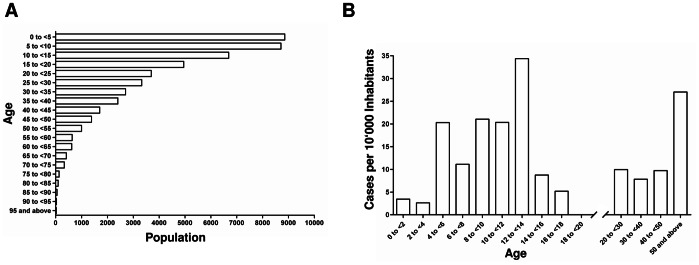
Population age distribution and age adjusted cumulative BU incidence rate in the Bankim HD.In the course of the exhaustive survey, data on the population age structure of the Bankim HD were collected (A). Using this age distribution and the ages of the RT-PCR confirmed BU cases which occurred inside of the Bankim HD (n = 62), the age adjusted cumulative BU incidence rate (cases per 1'000 inhabitants) for the duration of the study could be computed (B).